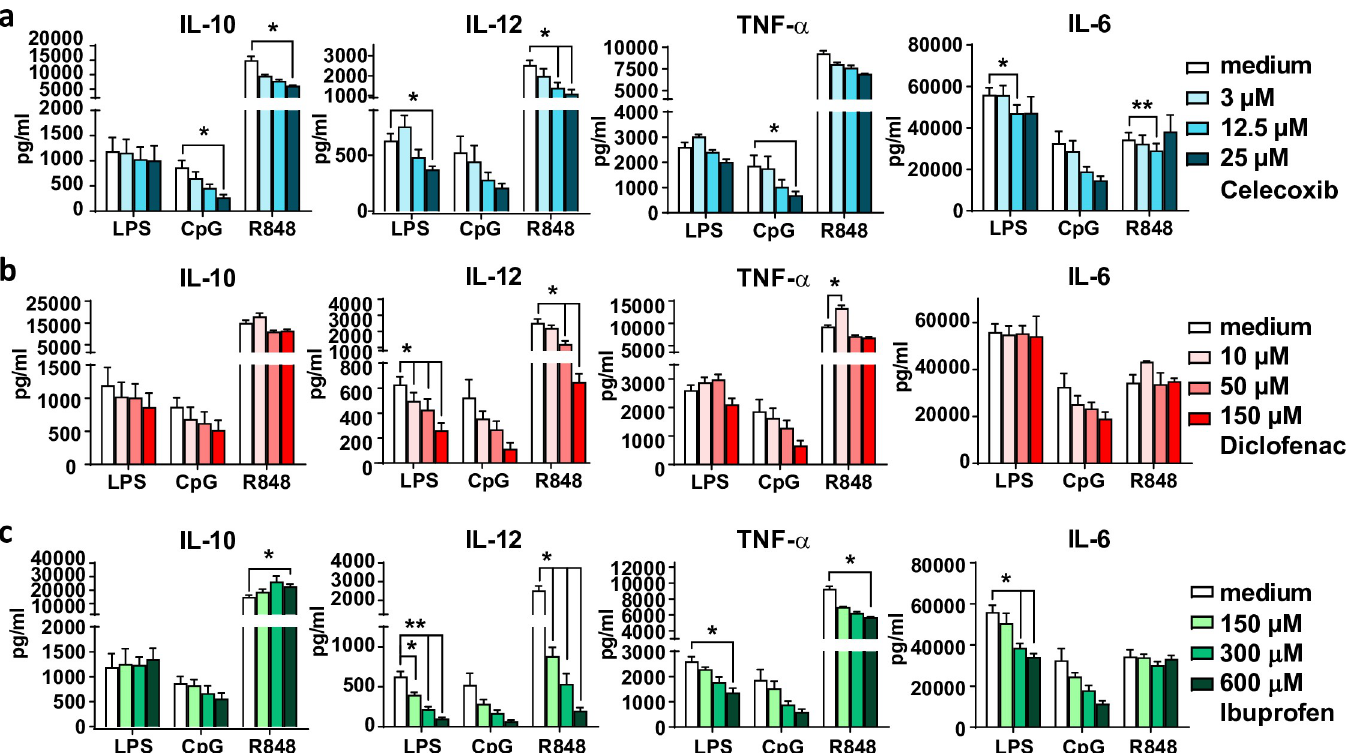
Fig 4. NSAID preincubation reduces TLR induced cytokine production. (a-c) mBMDCs were first pretreated with NSAIDs for 6 hr, followed by a 2.5 hr TLR stimulation with LPS, CpG, or R848. After overnight rest in fresh medium, cytokines were measured using ELISA (n = 4). IL-10, IL-12, TNF- α , and IL-6 production after TLR stimulation by (a) celecoxib, (b) diclofenac, and (c) ibuprofen preincubated DCs. Results are shown as means with SEM. Statistical significance was calculated using a one-way ANOVA with Dunnett’s multiple comparison test, medium versus rest.